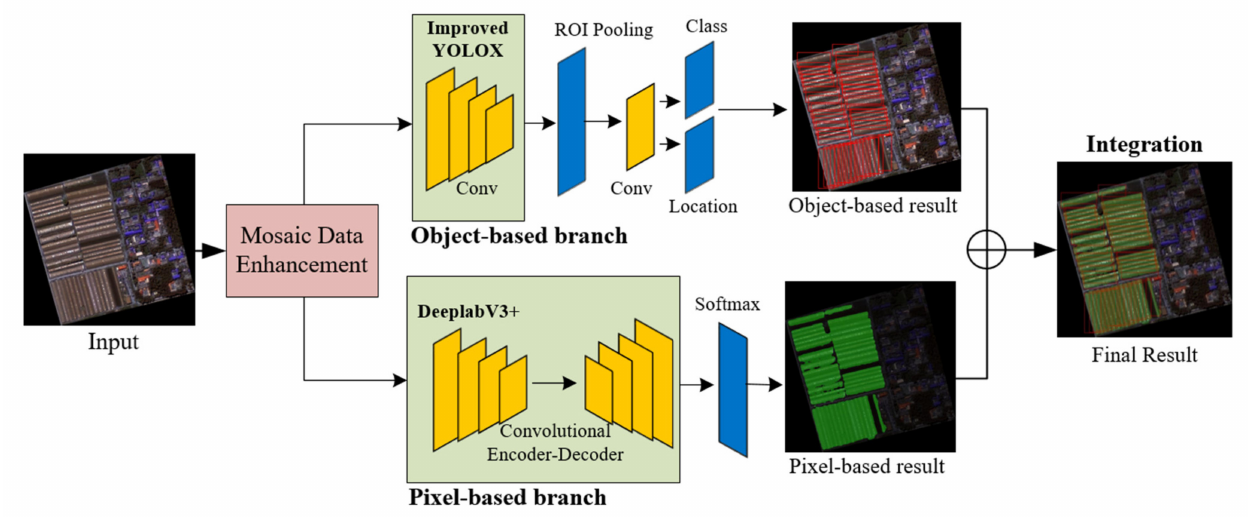
Figure 3. Algorithm flow